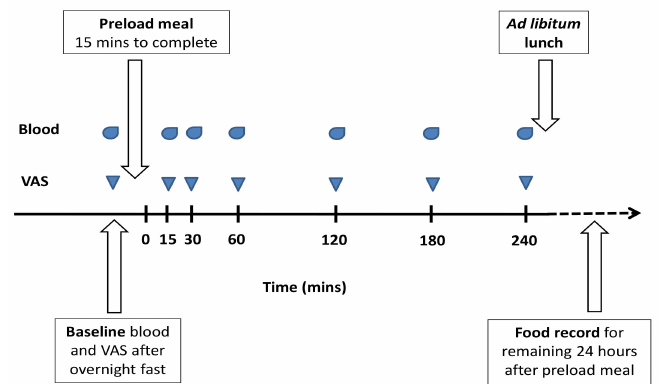
Figure 1. Testing day timeline. Oval shape indicates blood sampling and downwards triangle indicates hunger and fullness measures by visual analogue scales